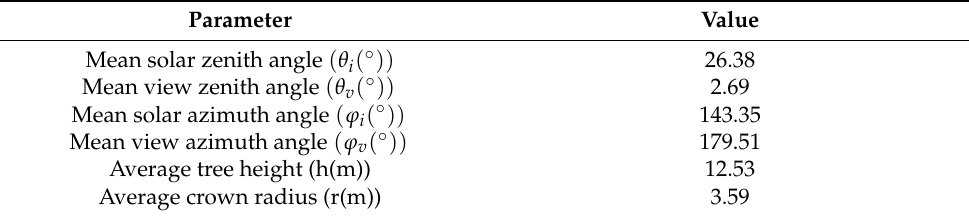
Table 16. Input parameters of the Li–Strahler GO model used to analyze a single scene image. Parameter